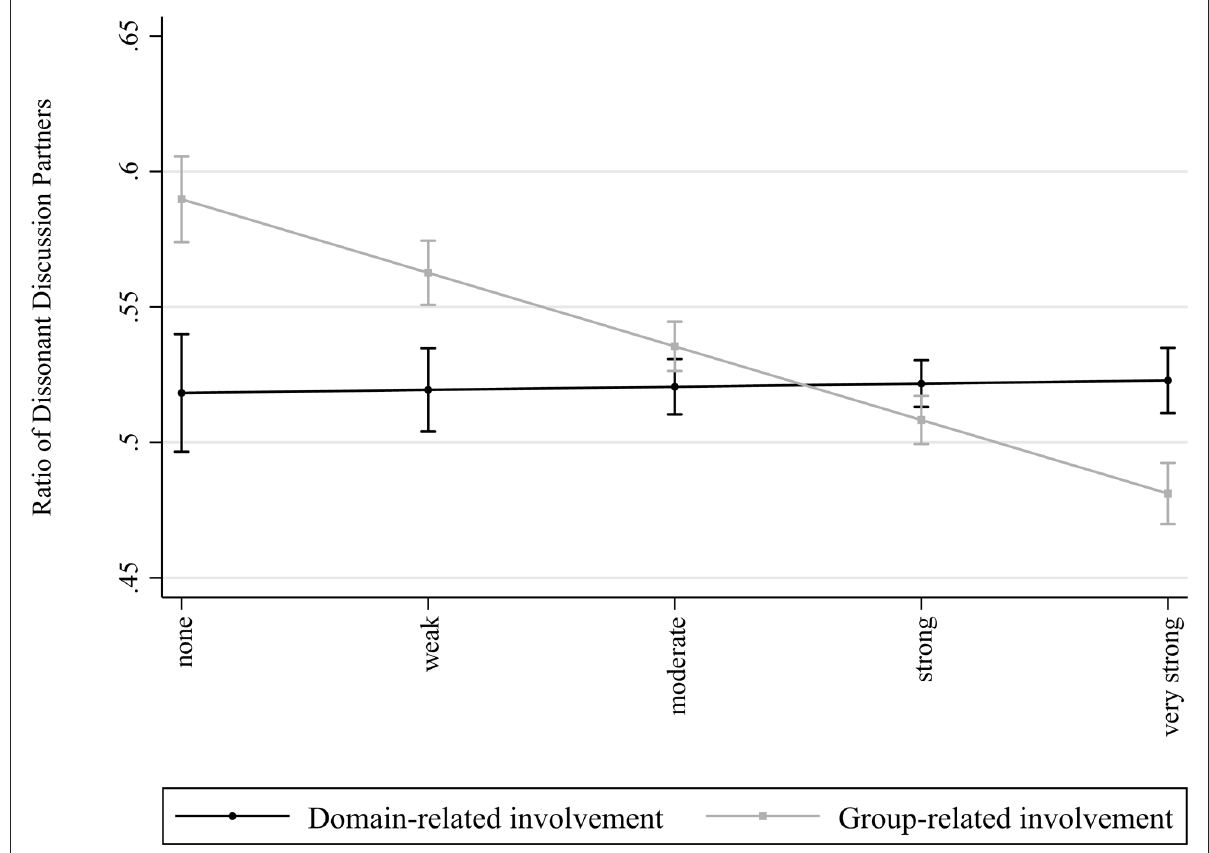
Figure 4: Predicted relative network heterogeneity by levels of political involvement. Note: Probabilities are predictions for men of average education and age; Source: ZA6804, Version